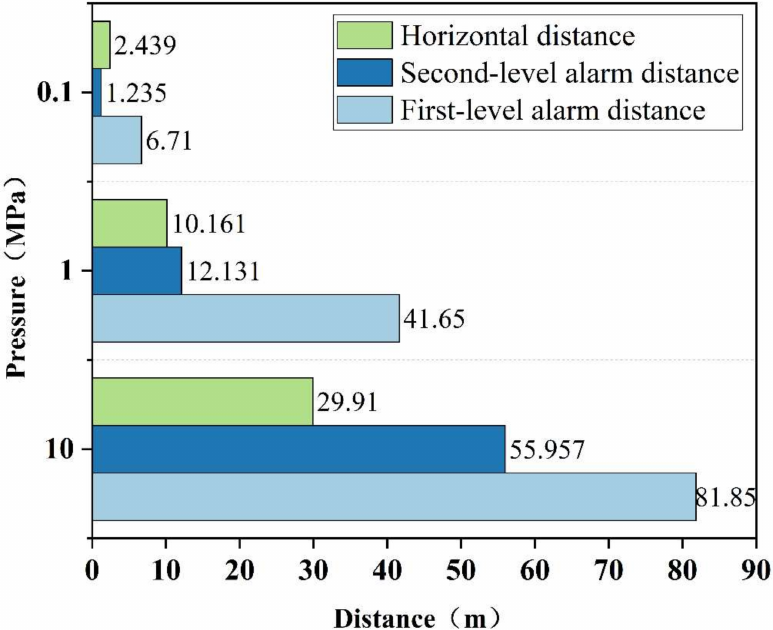
Figure 7. The relationship lines between the farthest alarm distance of combustible gas and medium pressure.